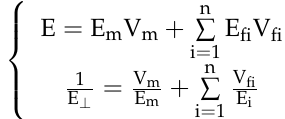
Figure 7. Stress–strain curves. Results of FEM analysis compared to measured data.